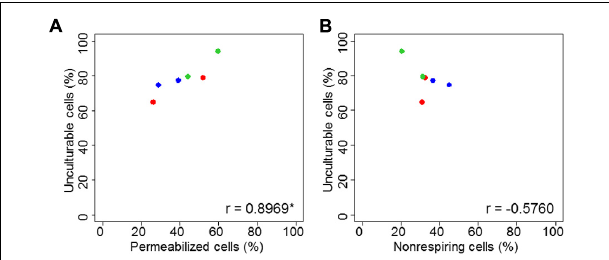
FIGURE 3 | Correlation plot of unculturable bacterial cells during drying as function of membrane permeability (A) and respiratory activity (B) . Correlation plots were proposed for C. sakazakii (red), S. Typhimurium (blue), and S. Senftenberg (green). “c” is the correlation coefficient and the “ ∗ ” indicates if correlation is significant, both obtained with Pearson correlation